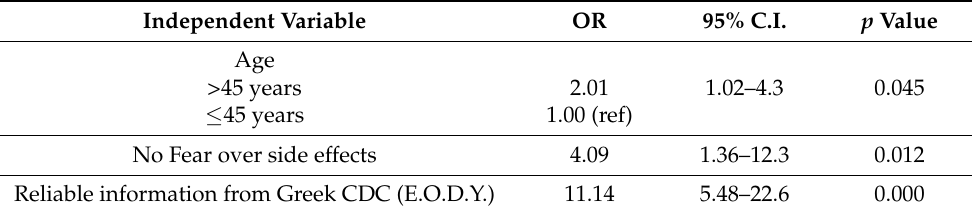
Reliable information from Greek CDC